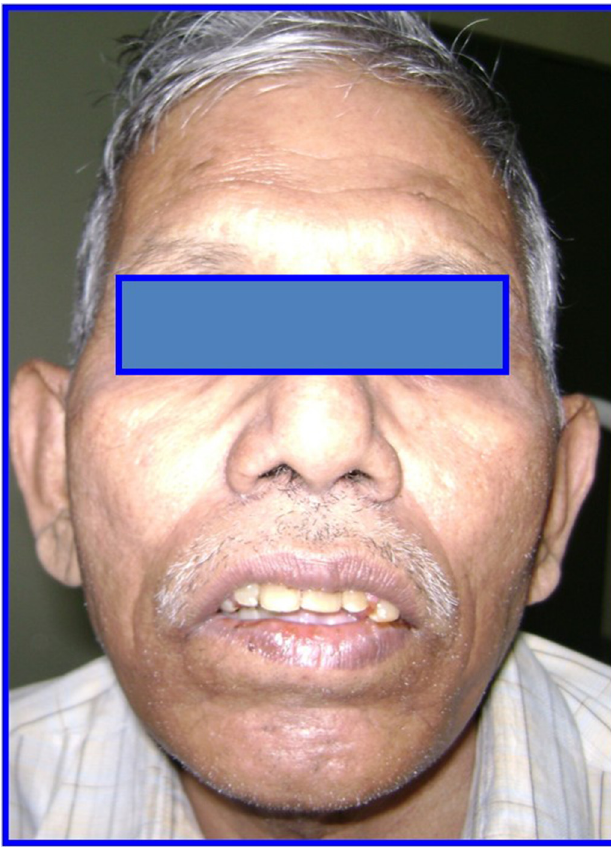
Fig. 1. Facial photograph with incompetent lips.